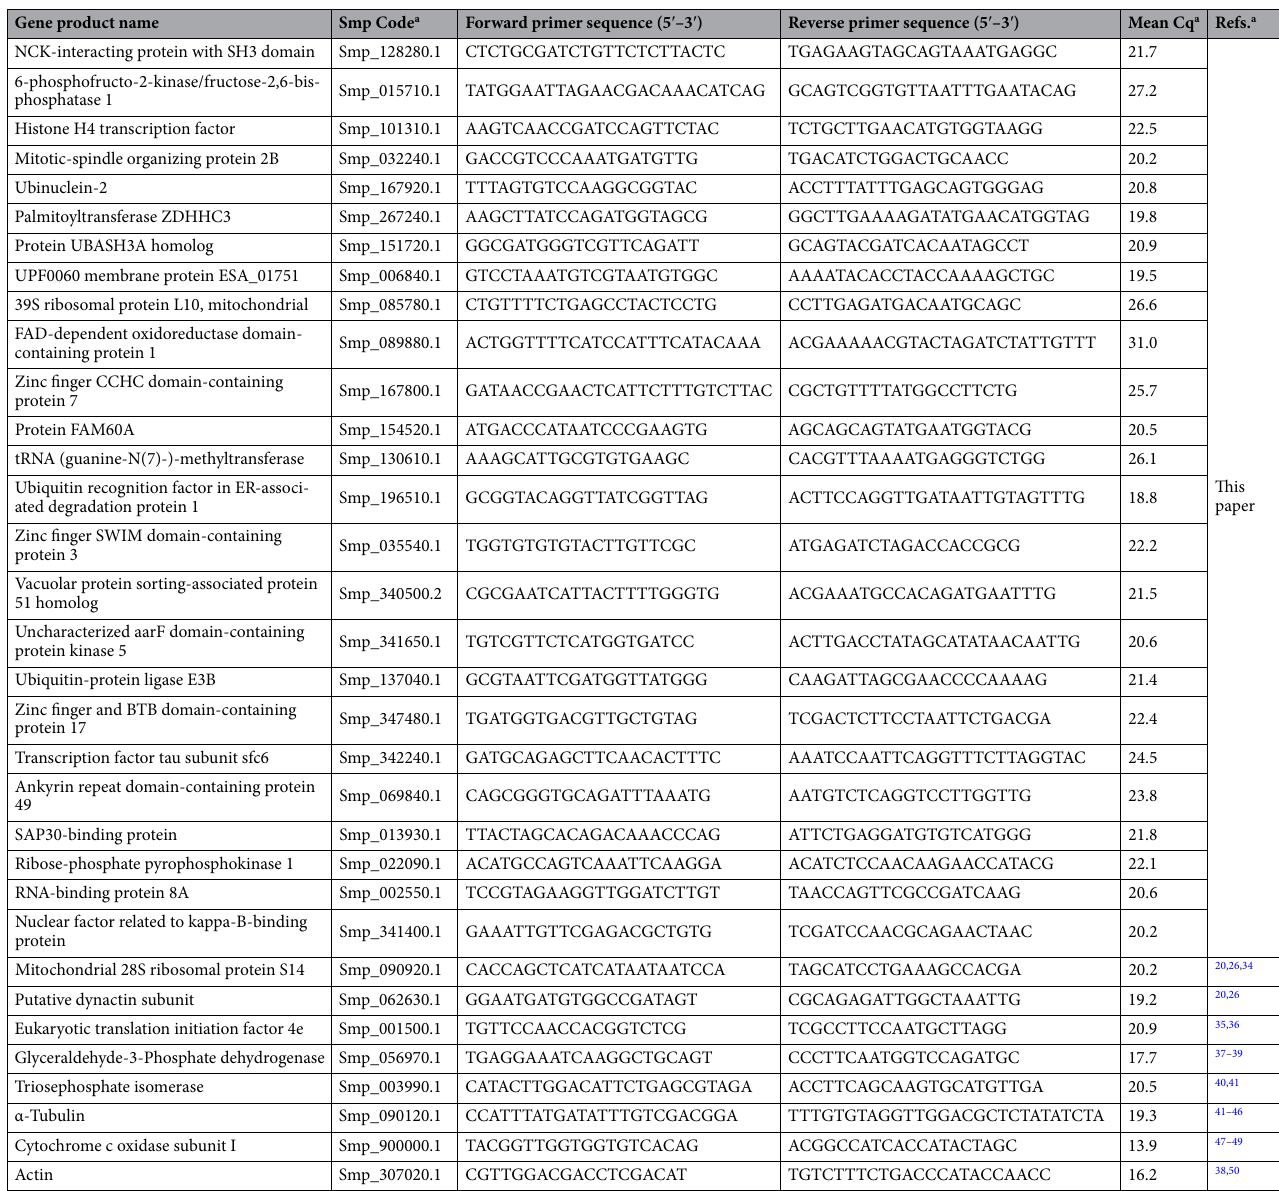
Table 1. Information on the RT-qPCR amplification characteristics of the 33 candidate reference genes. a Smp code stands for Schistosoma mansoni protein-coding gene ID. Mean Cq stands for Mean Corrected Cq, as described in the Methods. Refs. stands for the previous publications in which the corresponding primer pair of a reference gene was